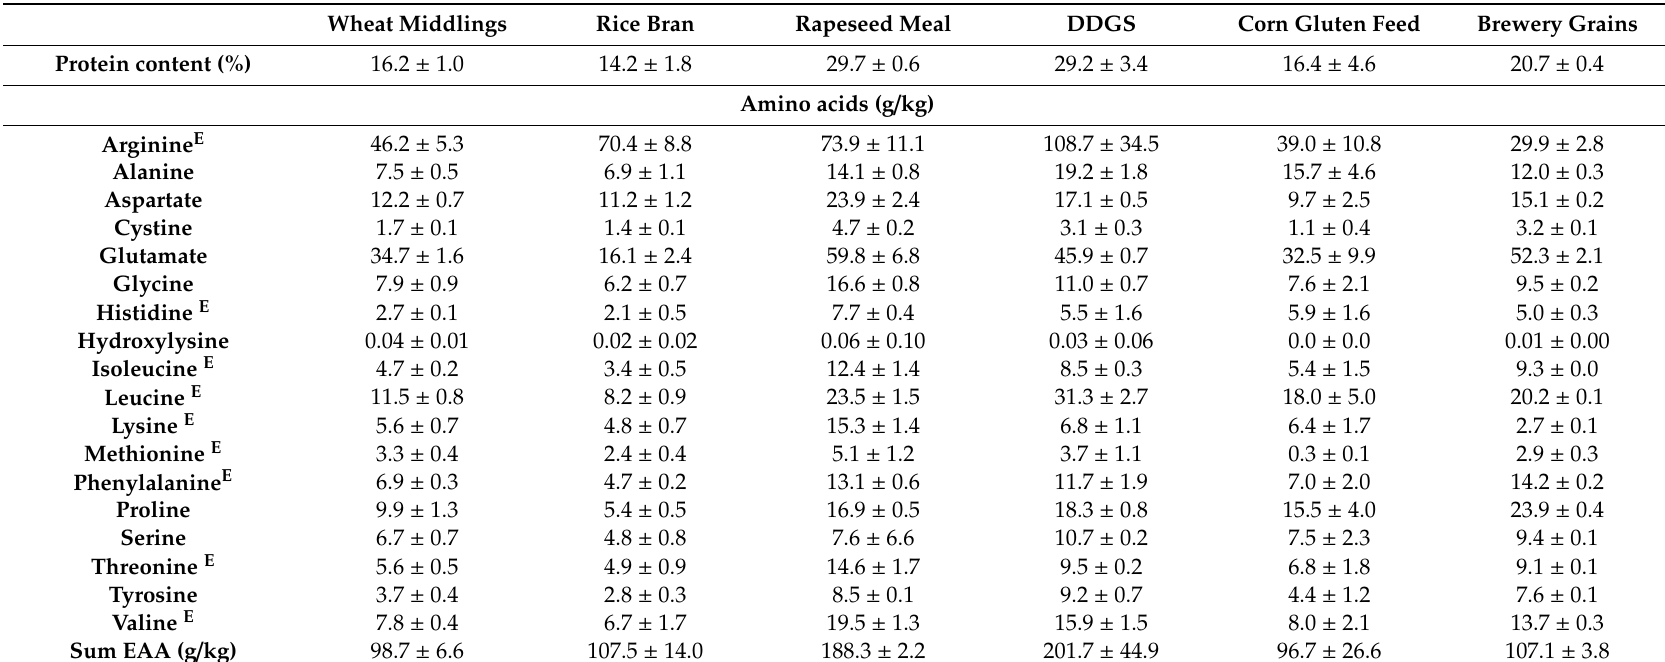
Table A1. Composition of side-stream ingredients (on dry matter basis, mean ±